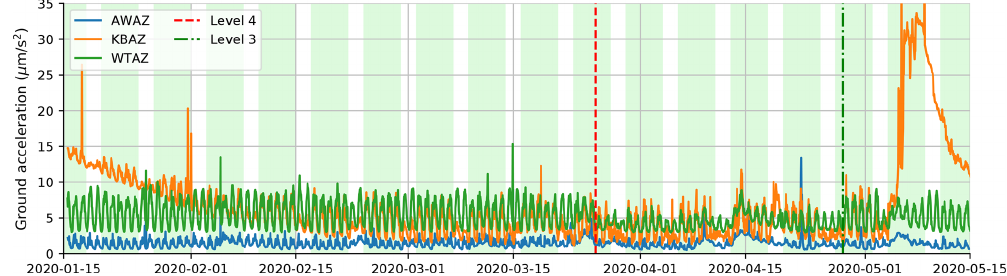
Figure 6. RSAM levels at three AVSN stations southwest of Auckland’s CBD. Only RSAM levels on station WTAZ dropped during the lockdown.